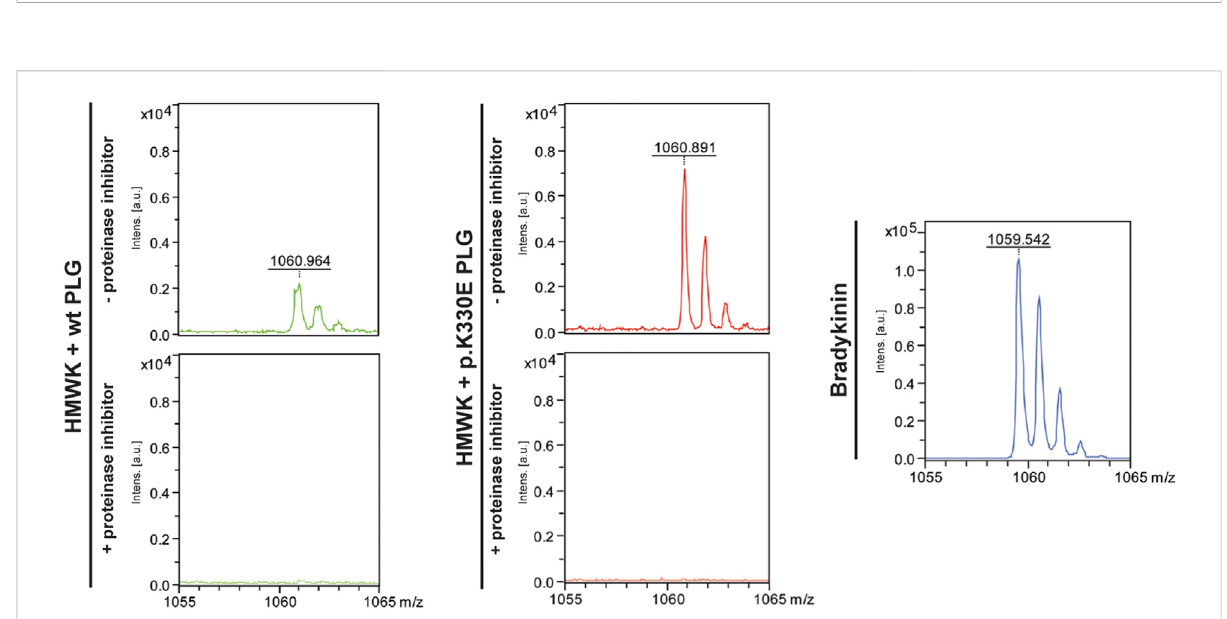
FIGURE 5 MALDI-TOF measurements for HMWK incubated with wt plasminogen and with mutant plasminogen (p.K330E) in the presence of proteinase inhibitor and without proteinase inhibitor, including the measurement of puri fi ed bradykinin as positive control (lower panel).